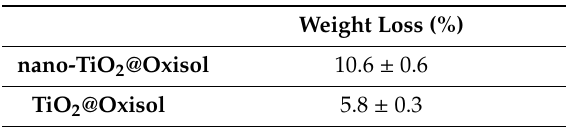
Table 3. Percentage functionalization of titanium dioxide detected via TGA method. The reported value is the average of at least three measures ± standard deviation (carried out both with the direct and indirect method).